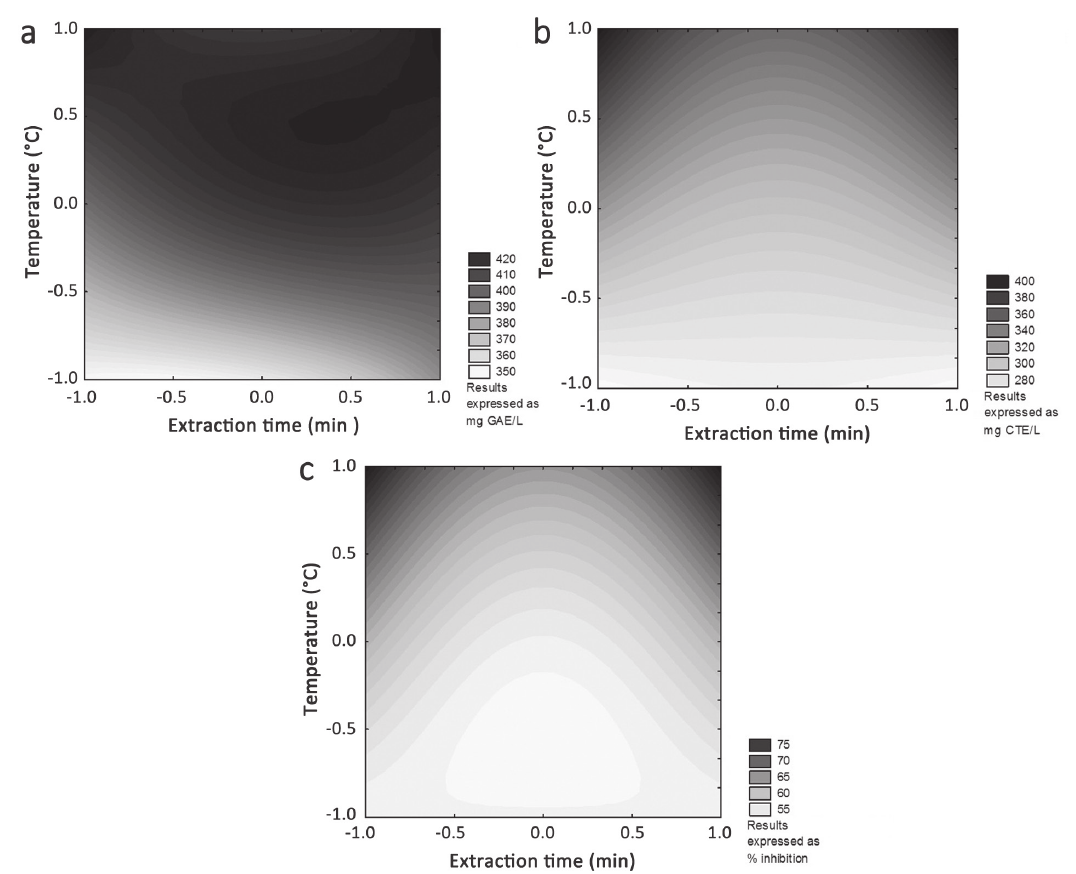
Figure 1 - Response surface plots to show the effect of extraction time (min) and temperature (°C) on the total content of phenolic compounds (A) , flavonoids (B) , and antioxidant activity towards DPPH (C) of roasted yerba mate